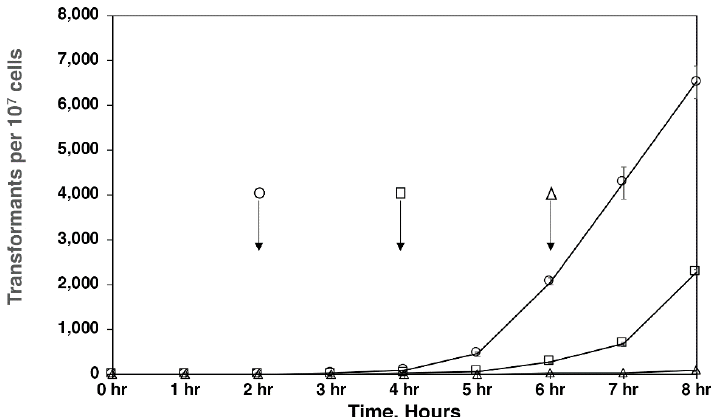
Figure 6. A. tumefaciens infection time course. C. neoformans and A. tumefaciens cells were mixed and filtered onto paper disks, which were then placed onto co-culture media with varying concentrations of agar for the indicated time. Experiments were performed in triplicate with three plates per experiment and counted hourly for 8 h. Colony counts are per 1 × 10 7 C. neoformans cells. Open circles indicate cells plated onto co-culture media solidified with 8% agar. Open squares indicate cells plated onto co-culture media solidified with 4% agar. Open triangles indicate cells plated onto co-culture media solidified with 1.5% agar. Arrows indicate time at which the first colony